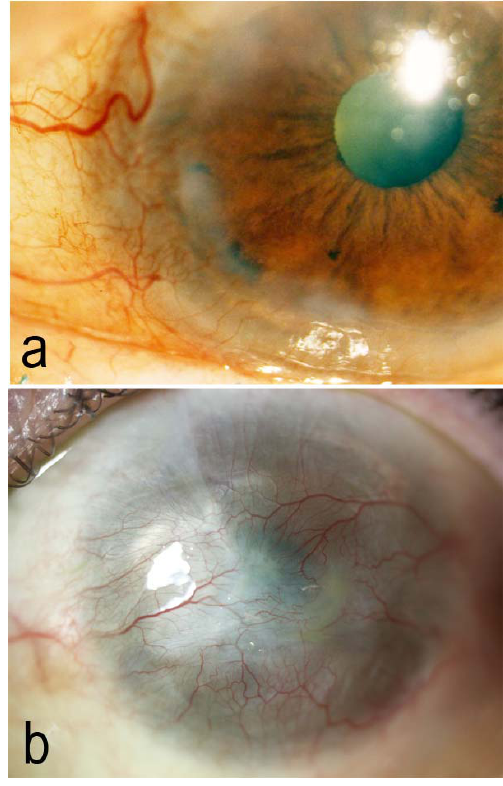
Figure 2. Clinical findings related to Limbal Stem Cell Deficiency (LSCD). Limbal deficiency secondary to ocular cicatricial pemphigoid with the presence of peripheral newly formed vessels leading to a loss of corneal transparency ( a ); Limbal deficiency, secondary to a chemical burn (bleach) of the ocular surface leads to a corneal conjuntivalization and neovascularization with loss of transparency ( b ). LSCD can be treated with cell therapy techniques such as cultured limbal epithelial transplantation (CLET) or cultured oral mucosal epithelial transplantation